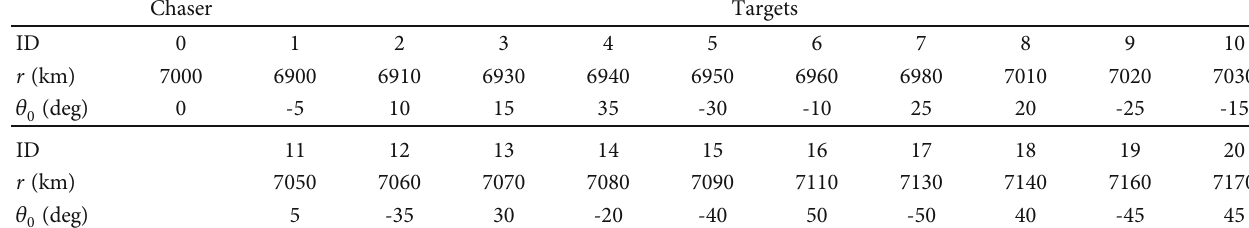
Table 2: Initial orbital parameters of chaser and targets.